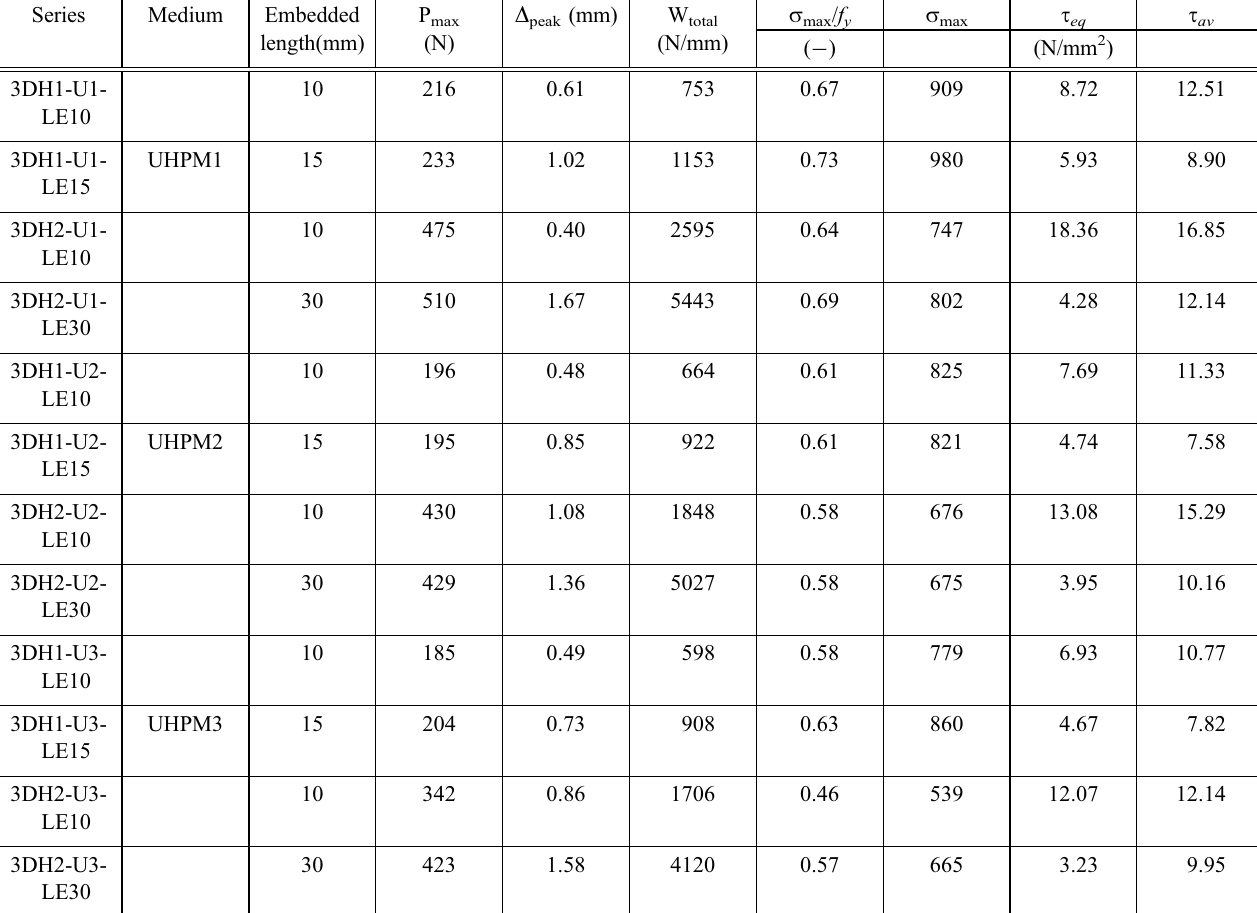
Table 4 The experimental parameters of pullout